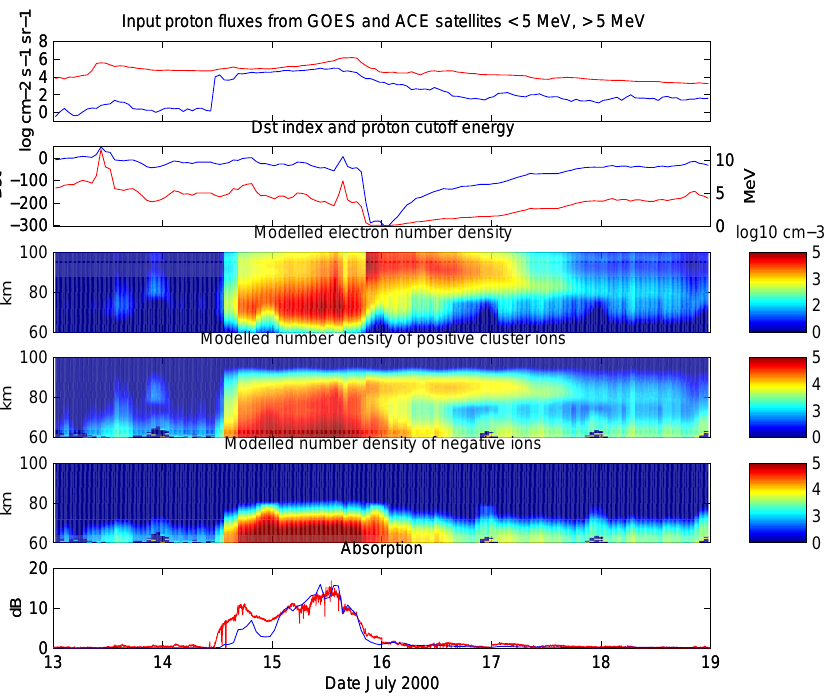
Fig. 1. The model results for 14–16 July 2000. Top panel: Solar proton fluxes from GOES 10 satellite: red- < 5MeV, blue- > 5MeV. 2nd panel: Dst index (blue) and proton cutoff energy (red). 3rd–5th panels: modelled densities of electrons, positive cluster ions and negative ions. Colour scale shows log density cm − 3 . 6th panel: cosmic noise absorption at 30MHz calculated from the model results (blue) and measured (red) by a riometer in